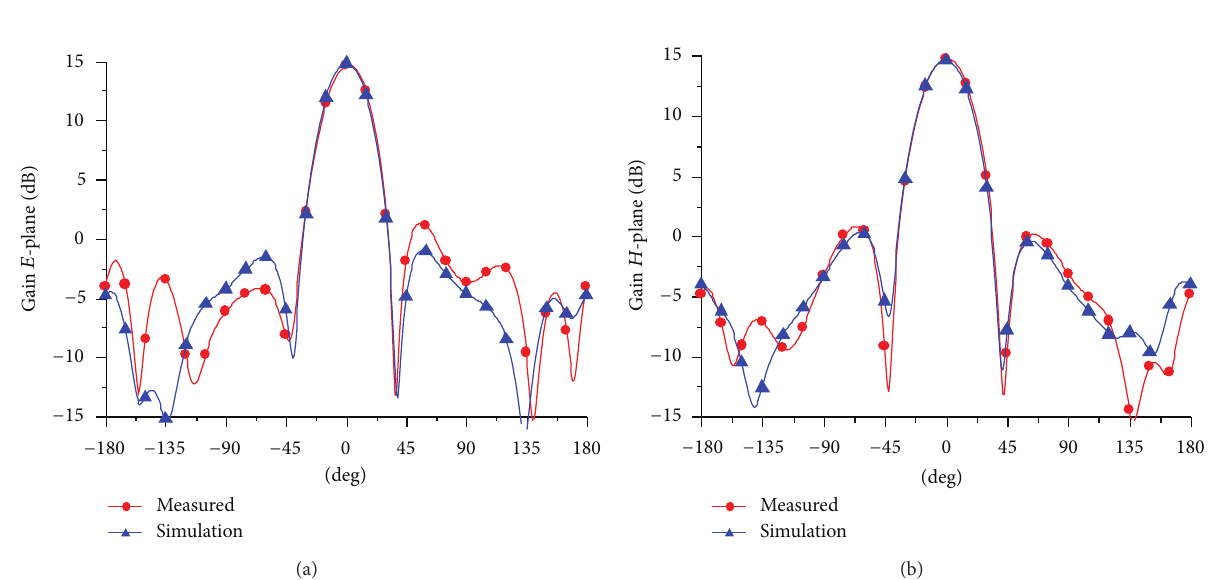
Figure 4: The radiation pattern of experimental array antenna at 5.35